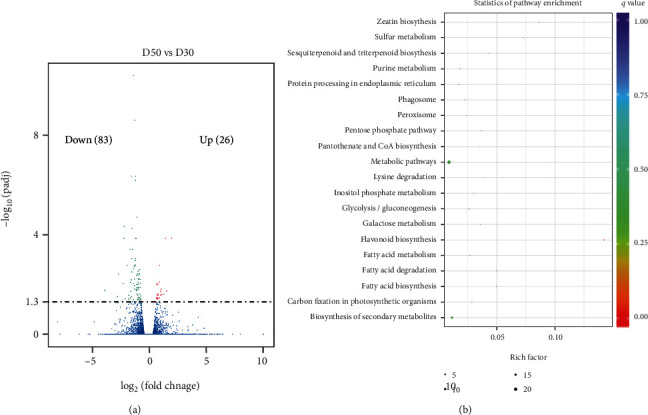
The differentially expressed genes (DEGs) between D50 and D30 irrigation regimes. (a) Shows the volcanic map of DEGs between D50 and D30. (b) Shows the results of KEGG pathway enrichment analysis.